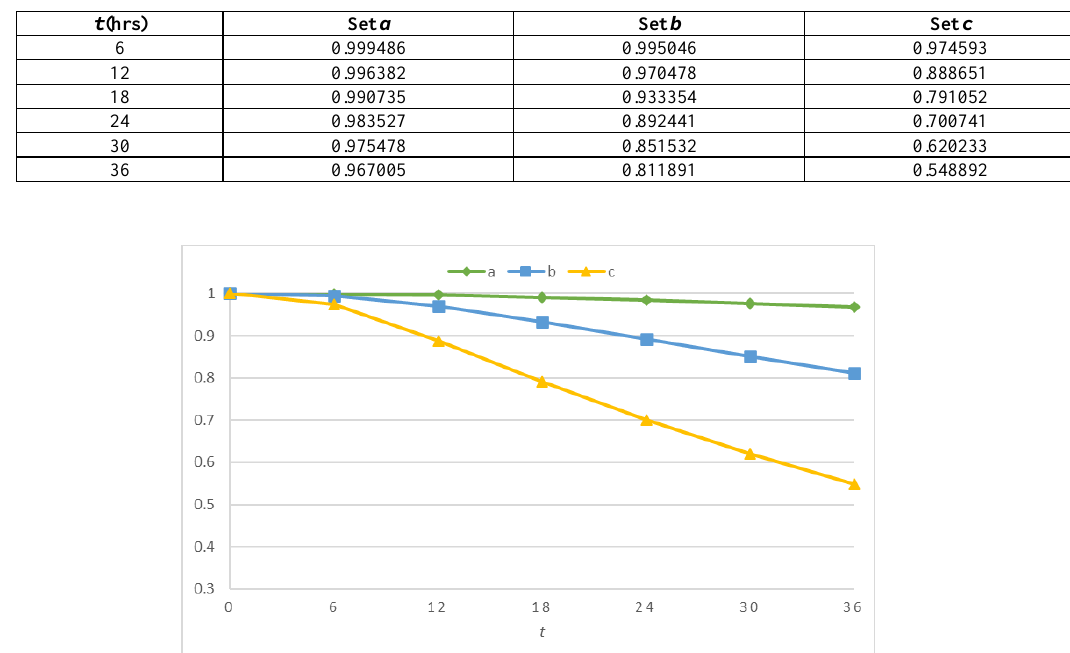
Figure 3. Impacts of parameters 𝜆